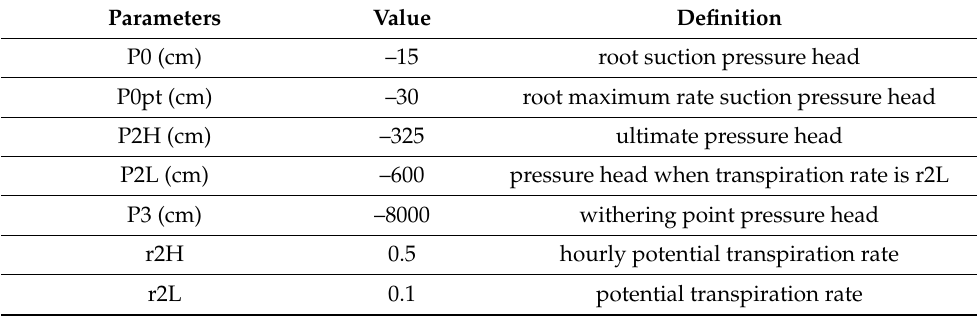
Table 1. Parameter configuration for water uptake rate of maize